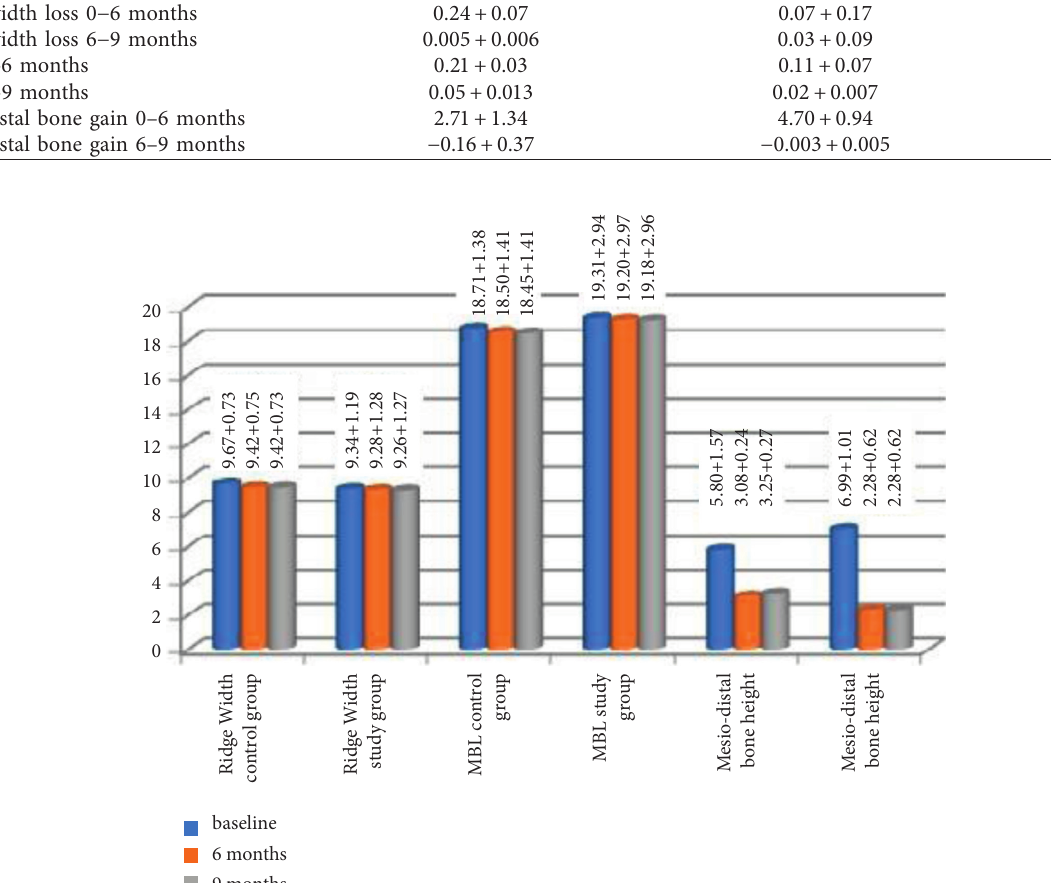
Figure 8: Bar chart representing the mean and standard deviation of radiographic measurement in the two studied groups in different observation